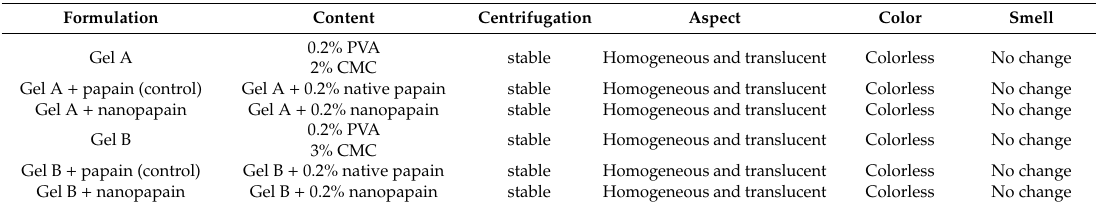
Table 2. Organoleptic properties observed during the stability assessment.